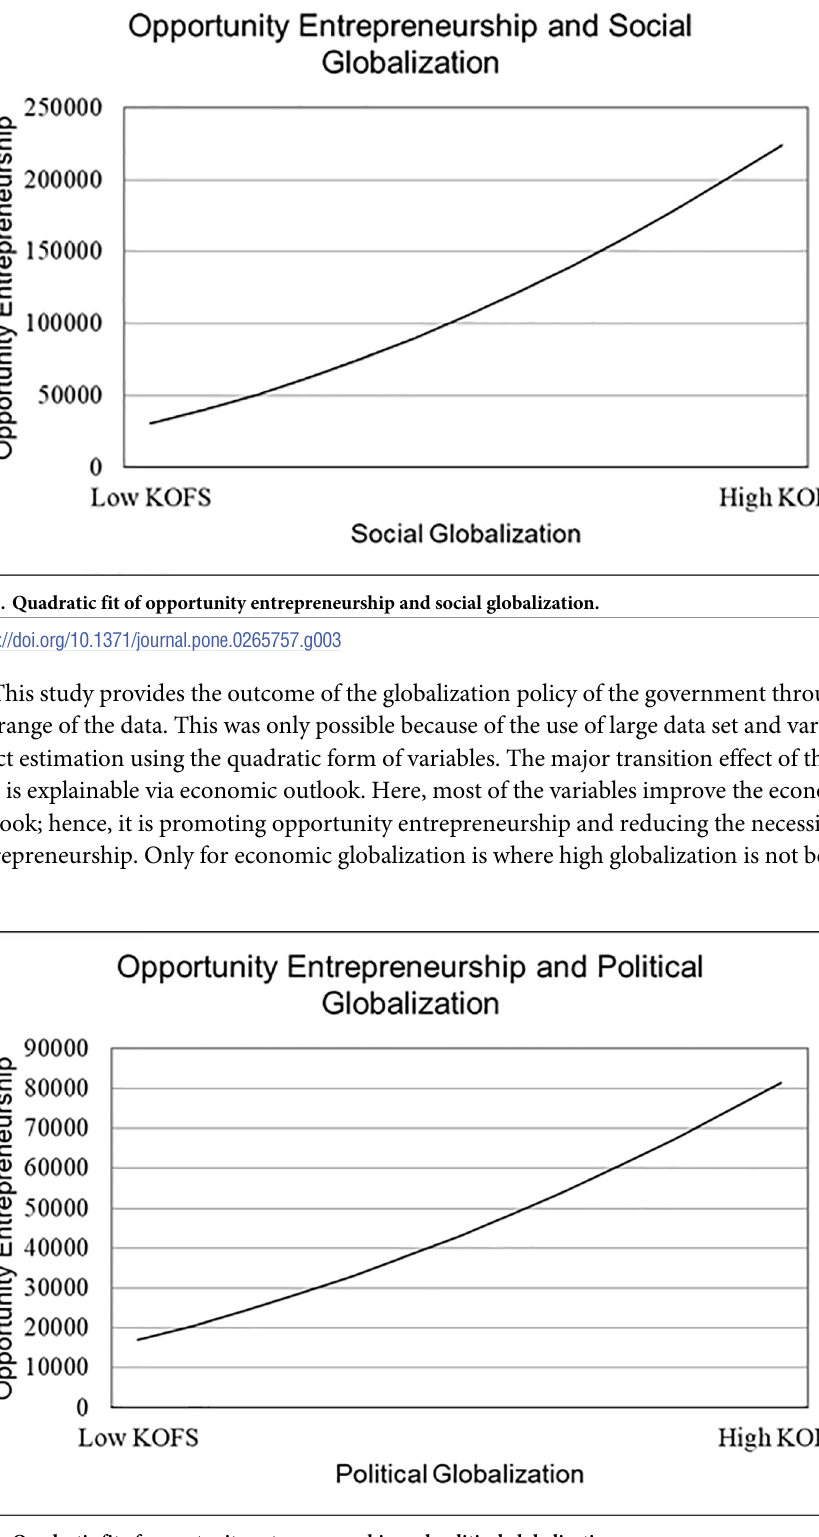
Fig 4. Quadratic fit of opportunity entrepreneurship and political globalization.